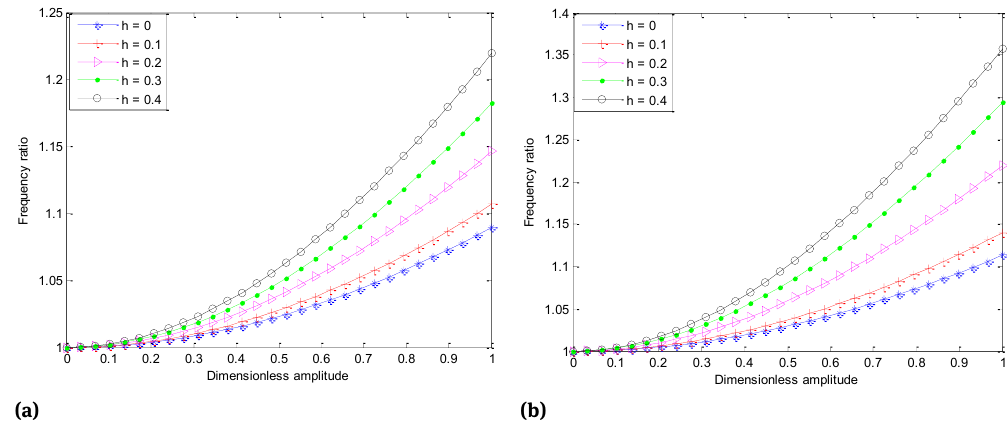
Figure 6: (a) Effects of dimensionless nonlocal parameter on the frequency ratio for simply supported nanobeam (b) Effects of dimension- less nonlocal parameter on the frequency ratio for clamped-clamped nanobeam